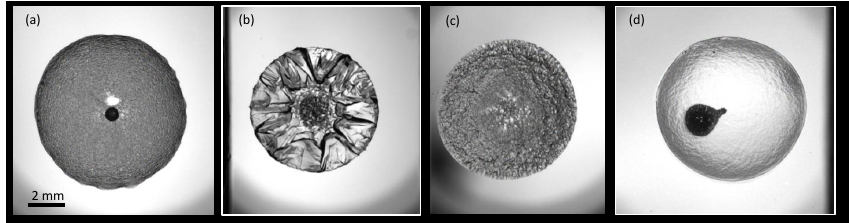
Figure 12. Methane hydrate formed from various aqueous systems subject to uniform temperature ( a ) Water + Methane system p = 4.00 MPa, T = 275.5 K ( b ) Water + Methane + MEG system, w MEG = 10%, p = 5.99 MPa, T = 276.8 K ( c ) Water + Methane + NaCl system, w NaCl = 5.44%, p = 6.66 MPa, T = 277.1 K ( d ) Water + Methane + PVP system, w PVP = 0.1%, p = 6.13 MPa, T = 275.2 K.